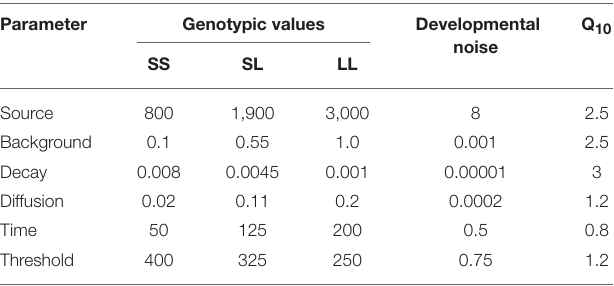
TABLE 2 | Genotypic values, developmental noise and Q 10 values for the parameters in the developmental model.